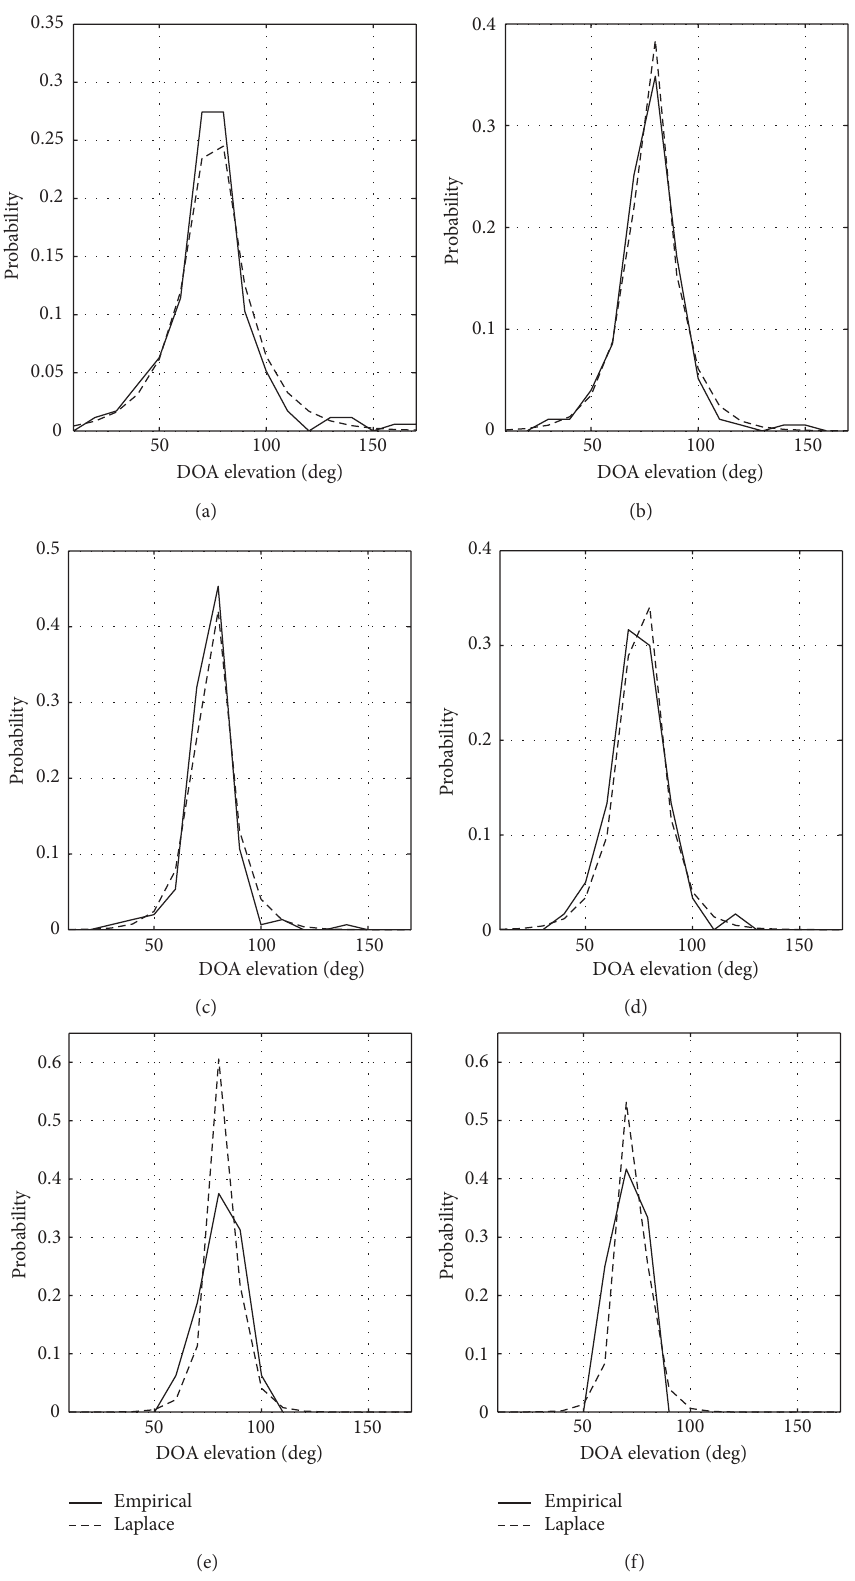
Figure 8: Set of DOA elevation pdf conditioned on (a) 0 ≤ 𝜏 < 20 ns, (b) 20 ≤ 𝜏 < 40 ns, (c) 40 ≤ 𝜏 < 60 ns, (d) 60 ≤ 𝜏 < 80 ns, (e) 80 ≤ 𝜏 < 100 ns, and (f) 100 ≤ 𝜏 < 120